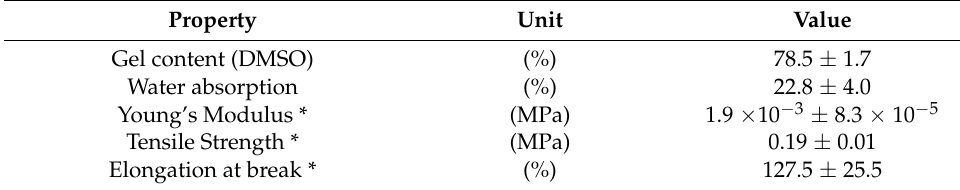
Table 2. Polyester properties: gel content, water absorption, and tensile properties.